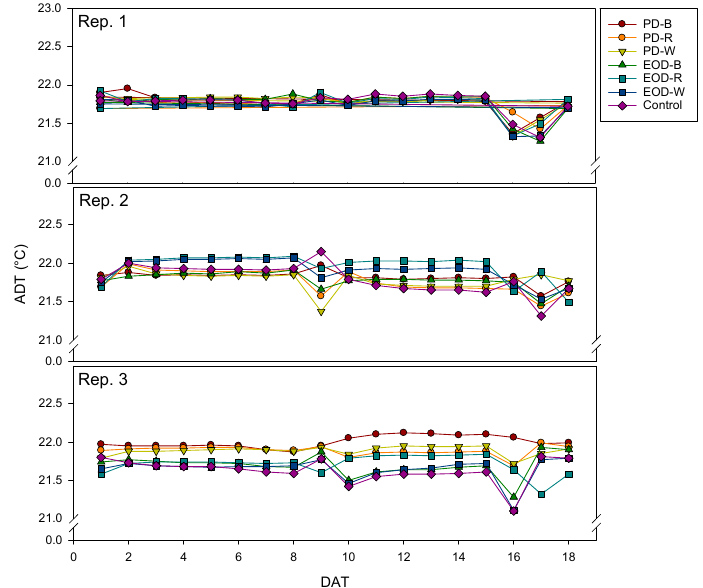
Figure 2. Average daily near-canopy air temperature (ADT) measured during each experimental replication. PD = pre-dawn; B = blue; R = red; W = white; EOD = end-of-day; DAT = day after transplanting.